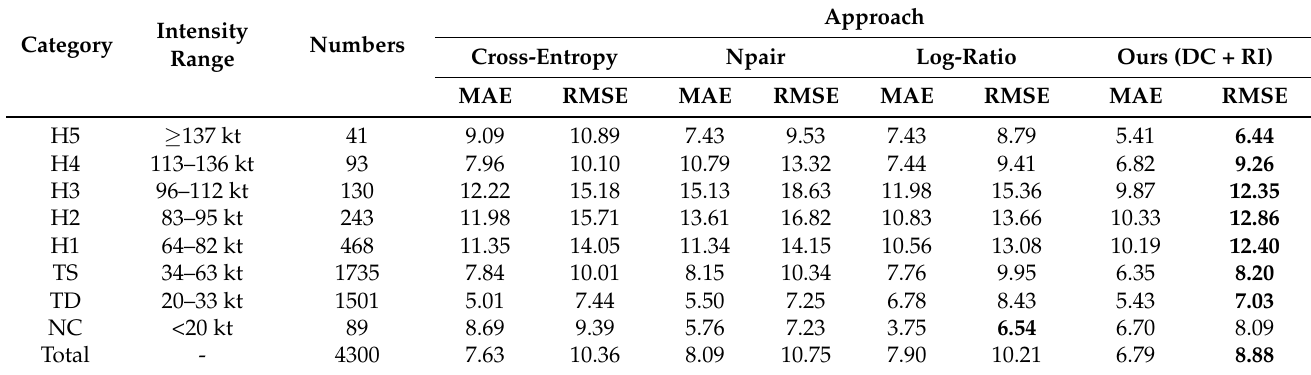
Table 2. Tropical cyclone estimation results compared with other methods. Bold numbers denote the best results. We divided tropical cyclones into eight categories by SSHWS based on their intensity and we counted the number of each category in the table. Additionally, we used MAE and RMSE as the evaluation metrics.